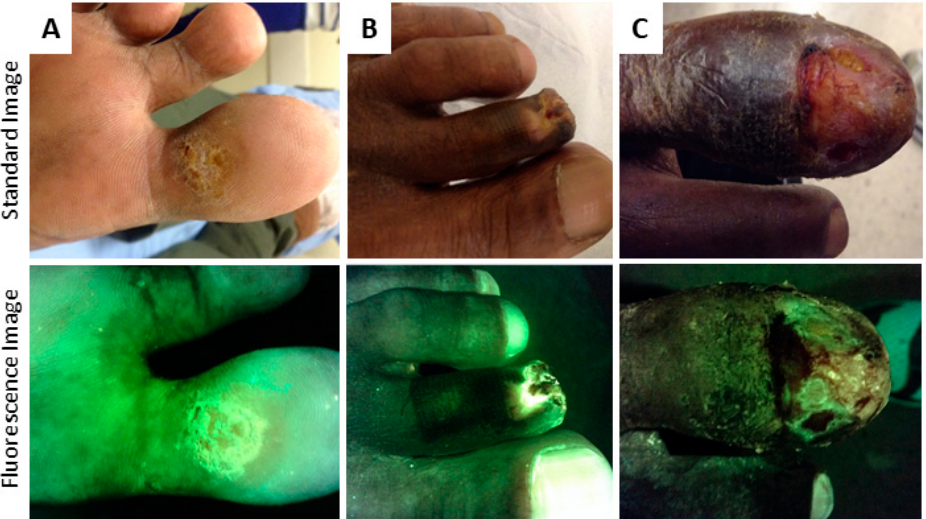
Figure 4. Variation in green fluorescence due to skin tone. ( A ) Lighter skin tones fluoresce a light green colour. As melanin concentration increases ( B , C ), the tone of green in the fluorescence images also darkens due to absorption of excitation light preferentially by melanin causing attenuation of the tissue fluorescence.